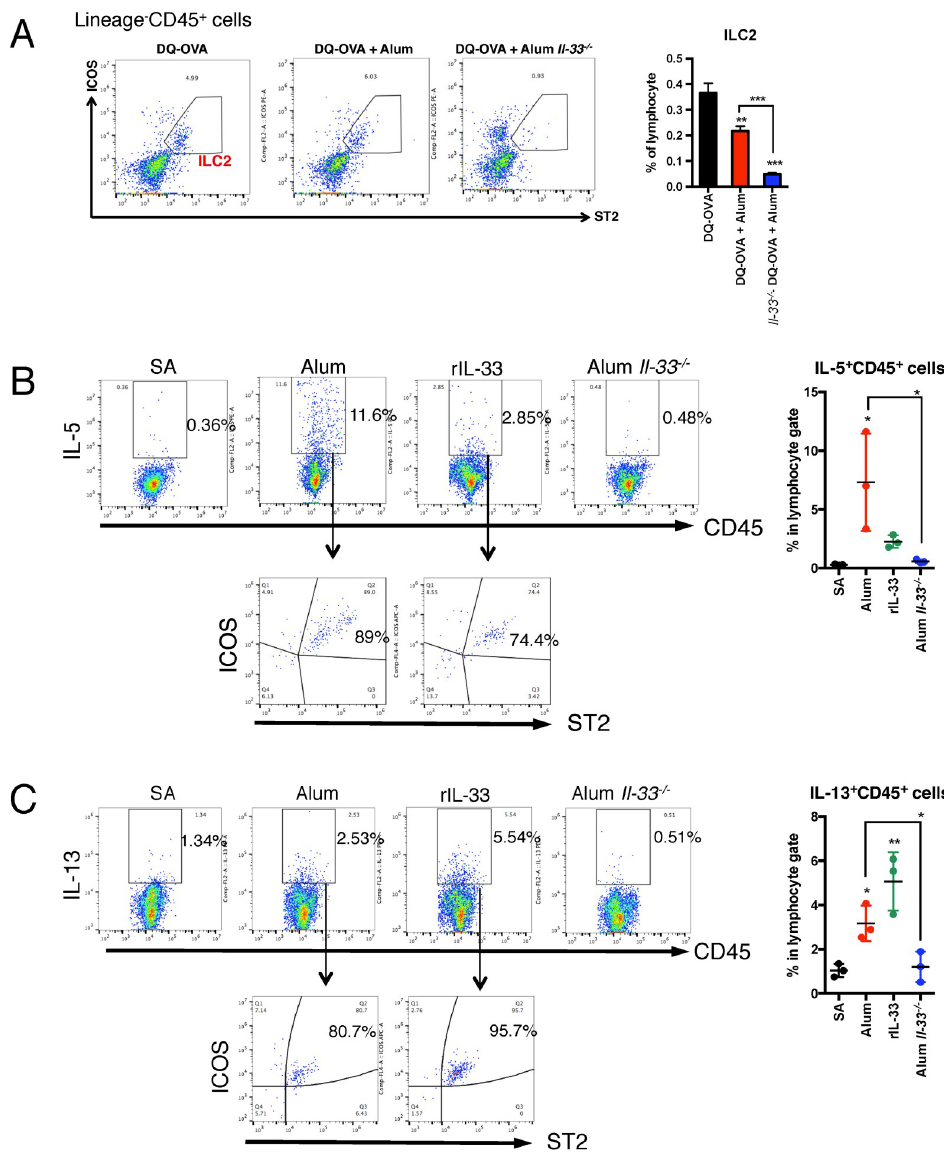
Fig 4. Alum increases IL-5 and IL-13 expression in lung ILC2s but does not induce ILC2 accumulation in the lung. WT or Il33 -/- mice were intranasally administered SA or alum. At 6 h after administration, the mice were euthanized, and the lungs were collected. ILC2s in the lung were gated as live (propidium iodide negative) CD45 + Lineage (B220/Fc ε RI/CD11b/CD3 ε /SiglecF) - ICOS + ST2 + ( A ). The ILC2 percentage of CD45 + cells was determined for each group ( A ). Intracellular staining with anti-IL-5 Ab ( B ) or anti-IL-13 Ab ( C ) was performed to determine their expression levels in ILC2s. The rates of CD45 + IL-5 + or CD45 + IL-13 + cells were calculated. Intracellular staining experiments were performed using pooled single suspensions from three mice for each group. The data are from two independently performed experiments (A–C), and the error bars are presented as the mean ( ± SEM) of four mice per group (A–C). Each dot indicates the result of individual experiments (B and C). For more than three groups, significance was assessed using one-way ANOVA and Dunnett’s multiple-comparison test to determine differences between SA and other groups. The student’s t -test was used to compare two groups. p � < 0.05, �� p < 0.01 and ��� p < 0.001 compared with the DQ-OVA group (A) or SA group (B and